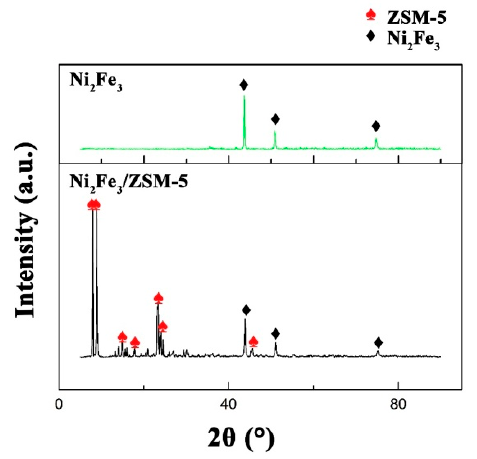
Figure 1. XRD analysis of prepared catalysts.